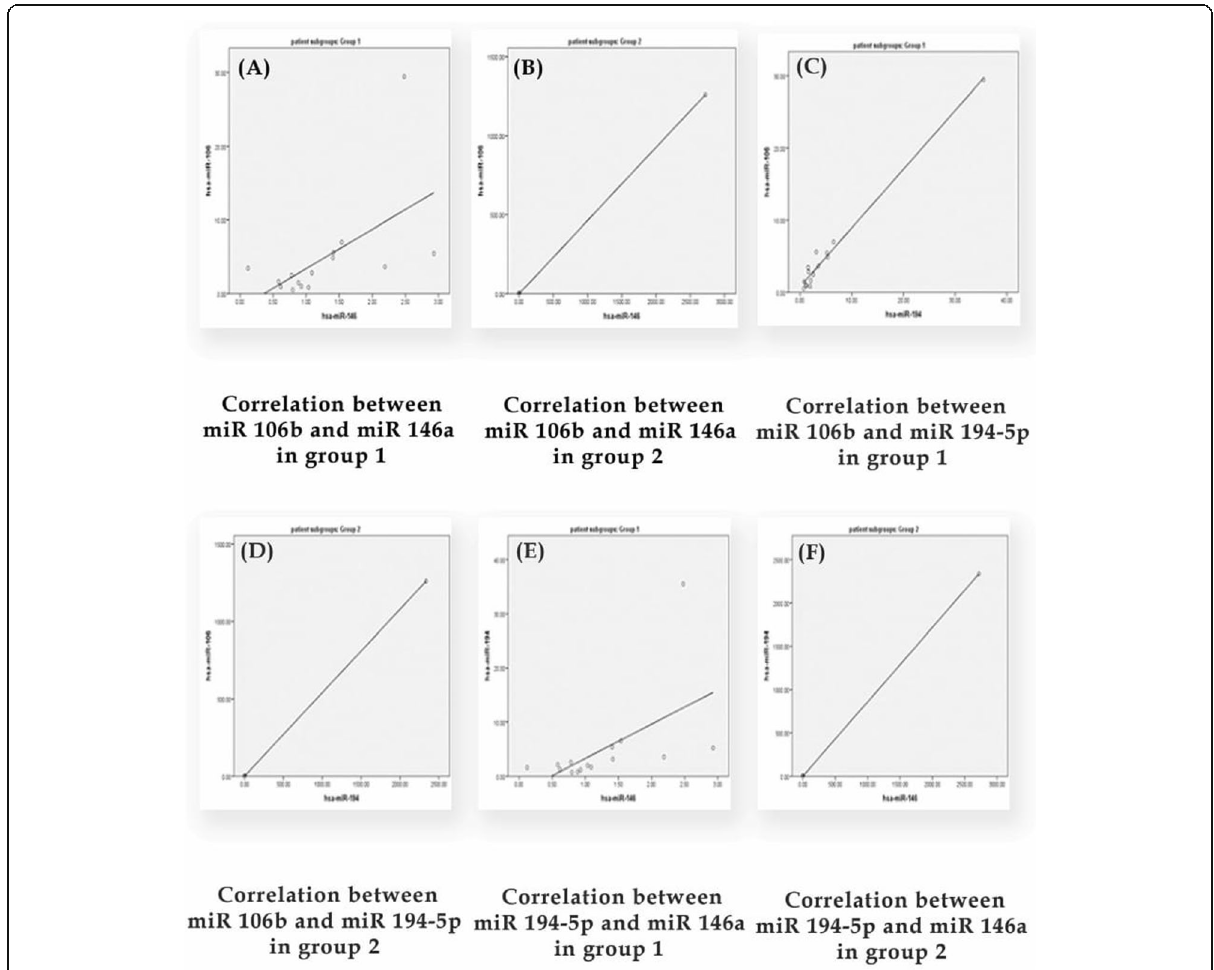
Fig. 2 The correlation between the 3 dysregulated miR (106b, 146a, and 194-5p) with each other in groups I and